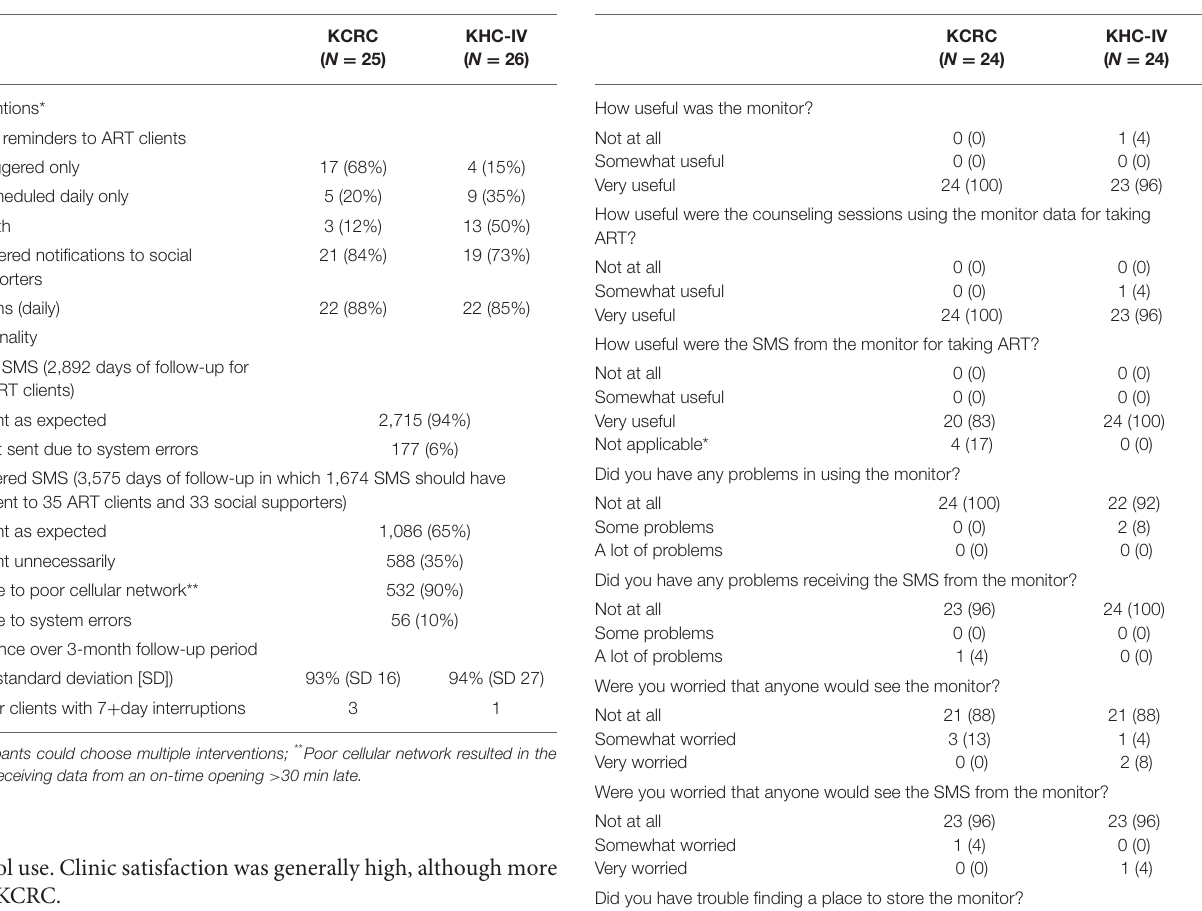
TABLE 2 | Intervention selection, functionality, and adherence outcomes. TABLE 3 | Acceptability of the monitors and associated